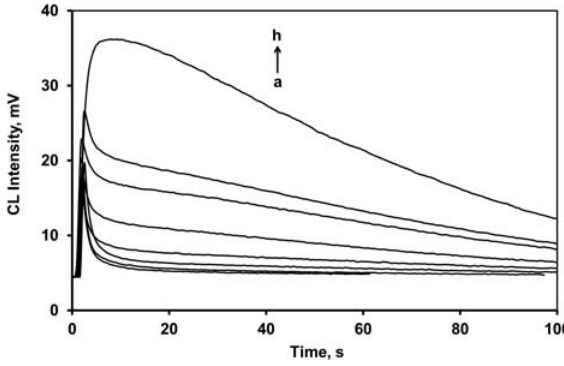
Figure 3 . Typical CL profiles for different concentrations of mepi- vacaine including: a) blank, b) 1.13, c) 9.05, d) 22.63, e) 45.25, f)